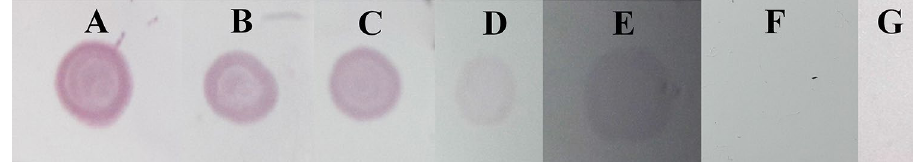
Figure 4. Titration of COVID-19 positive and negative sera. Where COVID-19 positives serum was diluted to A: 1:2; B: 1:4, C: 1:8; D: 1:16and E: 1:32. Negative serum (F) was diluted at 1:2. G: Blank (no serum).